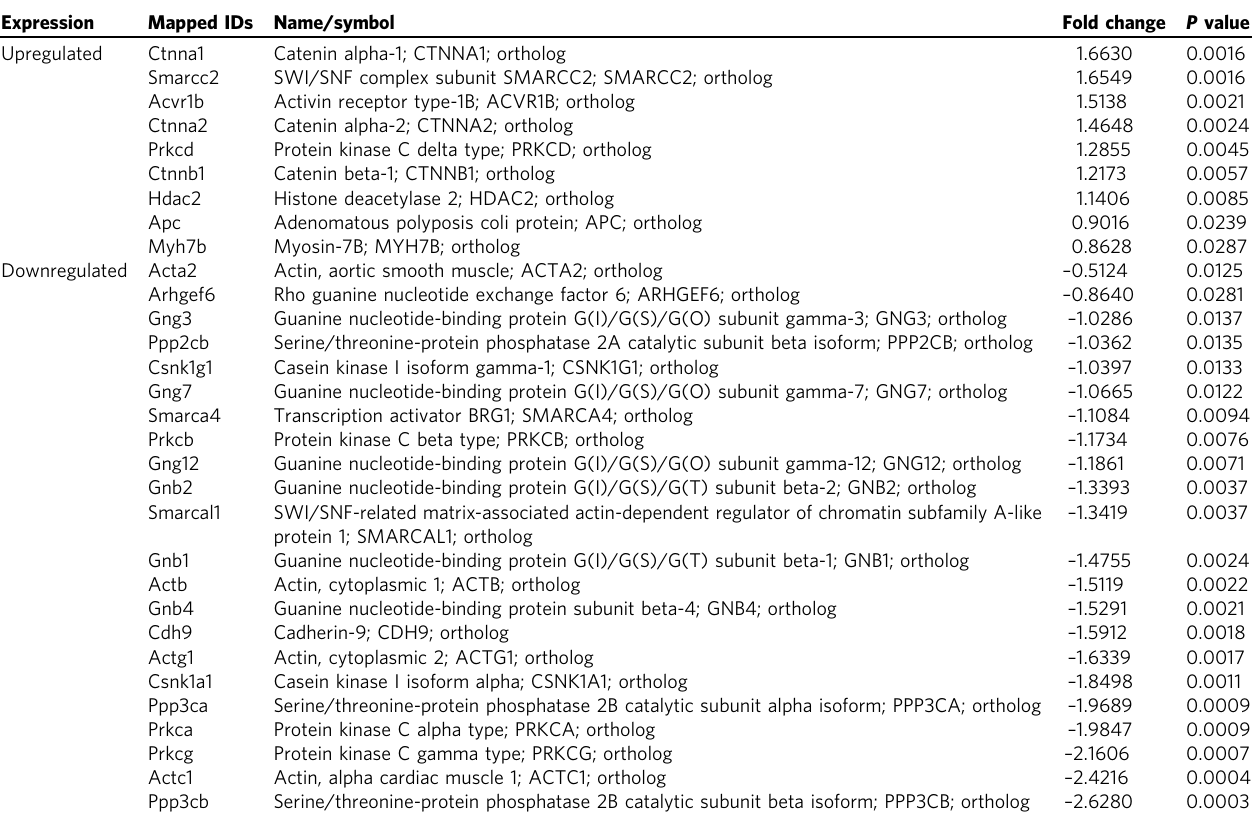
Table 2 DEPs in THRSP OE mice involved in Wnt signaling. Expression Mapped IDs Name/symbol Fold change P value